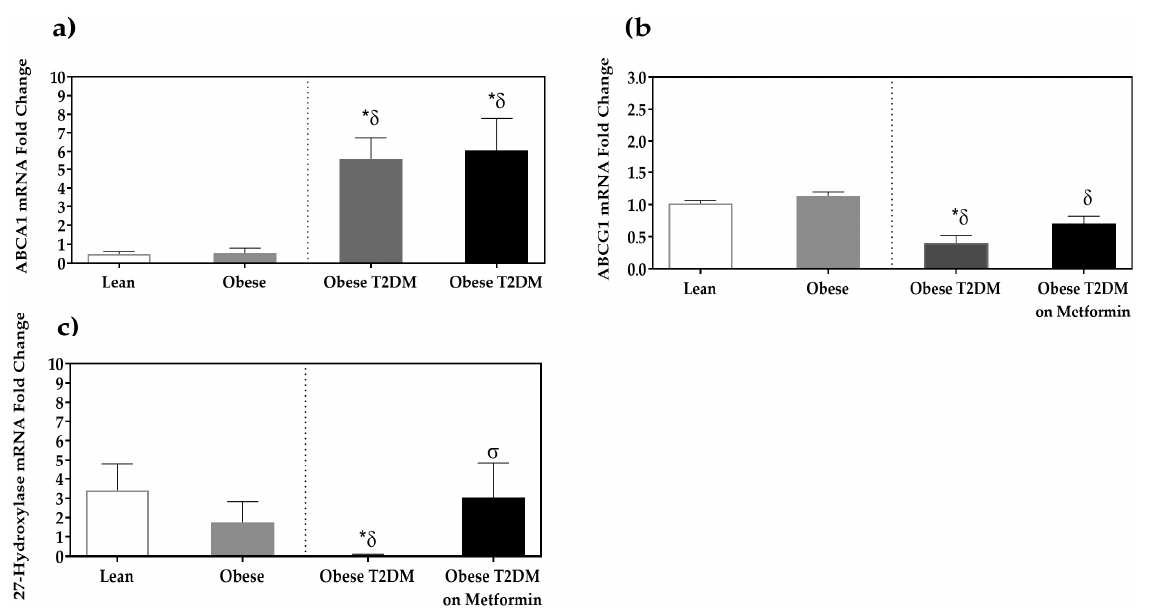
Figure 3. mRNA expression of cholesterol efflux proteins in the PBMCs of lean, obese, T2DM and T2DM on Metformin groups: ( a ) ABCA1; ( b ) ABCG1; and ( c ) Sterol 27-hydroxylase. Results are presented as Mean ± SEM. One-way ANOVA on ranks, p < 0.001 for ABCA1, ABCG1 and Sterol 27-hydroxylase, followed by Dunn’s test for pairwise comparisons and comparisons against normal-weight group, * p < 0.05 vs. normal ‐ weight subjects; δ p < 0.05 vs. obese; σ p < 0.05 vs. T2DM subjects.